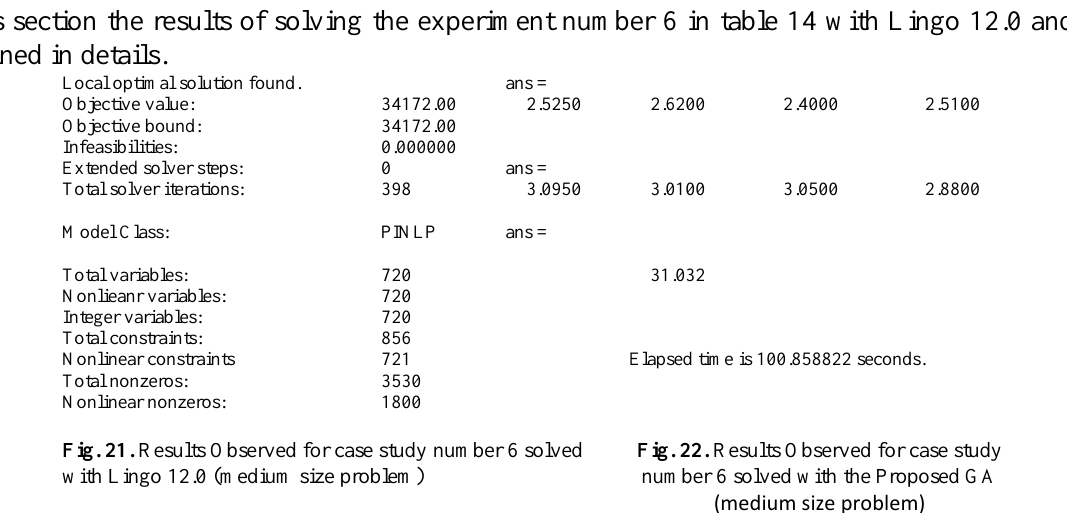
Fig. 22. Results Observed for case study number 6 solved with the Proposed GA (medium size problem)